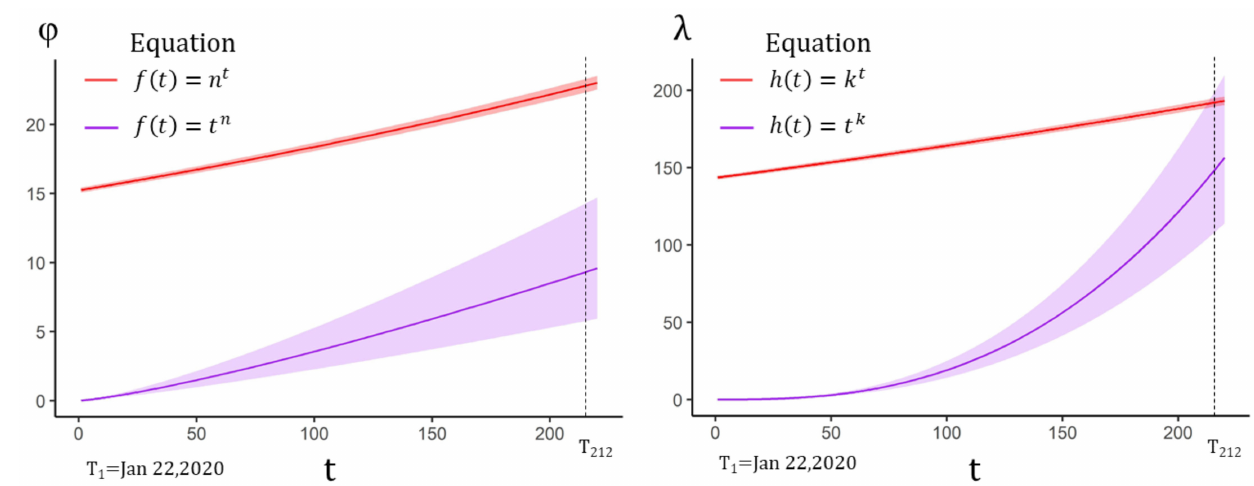
Figure 6. Time-varying UIR and RDR with 95%CI estimated by Equation (18). Equation (18) only provided the estimated values of UIR and RDR. Both the power function and the exponential function implied an increasing effect, wherein, the power function was much smaller than the exponential function in terms of UIR